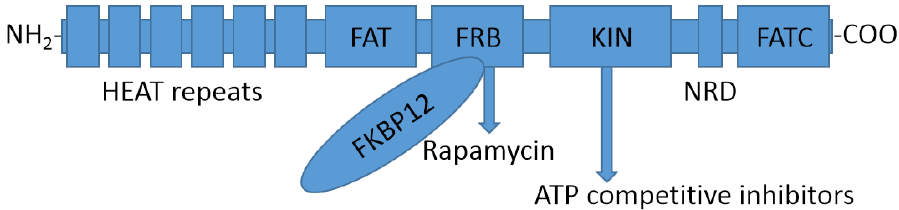
Figure 1. Primary structure and domain distribution of mTOR.